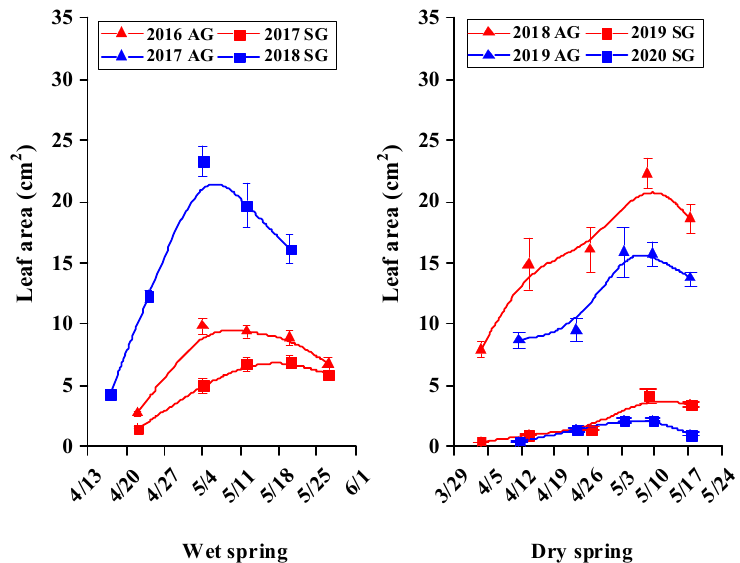
Figure 8. Increase in leaf area of spring (SG)- and autumn (AG)-germinating plants of Erodium oxyrhinchum in wet ( left ) and dry ( right ) springs. The first three periods represent the vegetative stage, and the last two periods represent the reproductive stage. Vertical bars indicate standard errors of the means (n = 8).